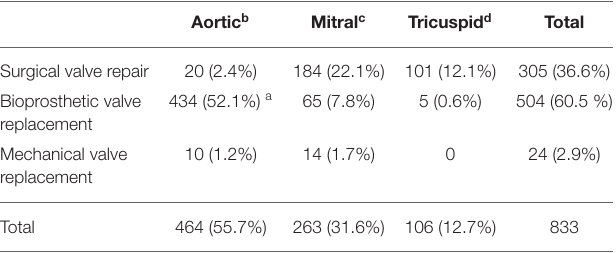
TABLE 3 | Overview of surgical valve repair and replacement at the University Hospitals Leuven in 2019. Aortic